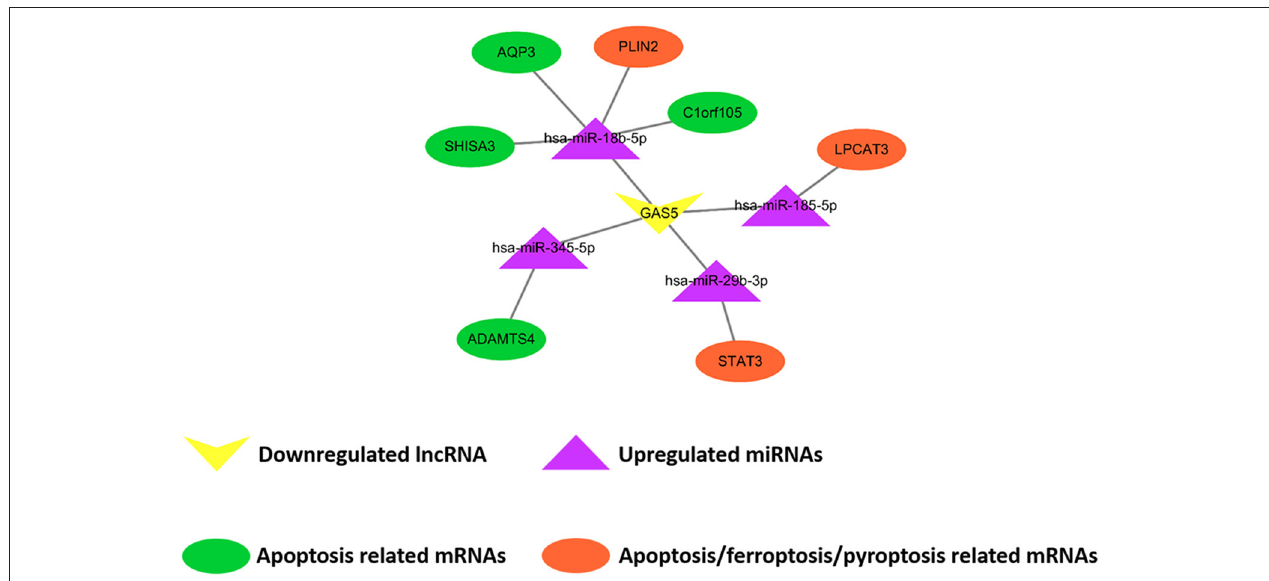
FIGURE 7 | Demonstration of proposed lncRNA GAS5-mediated ceRNA regulatory networks on programmed cell death. The rectangle, triangles, and circles represent lncRNAs, miRNAs and mRNAs, respectively. The circles highlighted in orange and green indicate apoptosis related mRNAs, the circles highlighted in orange indicate ferroptosis related mRNAs, and the circle highlighted in orange (STAT3) indicates pyroptosis related mRNAs.